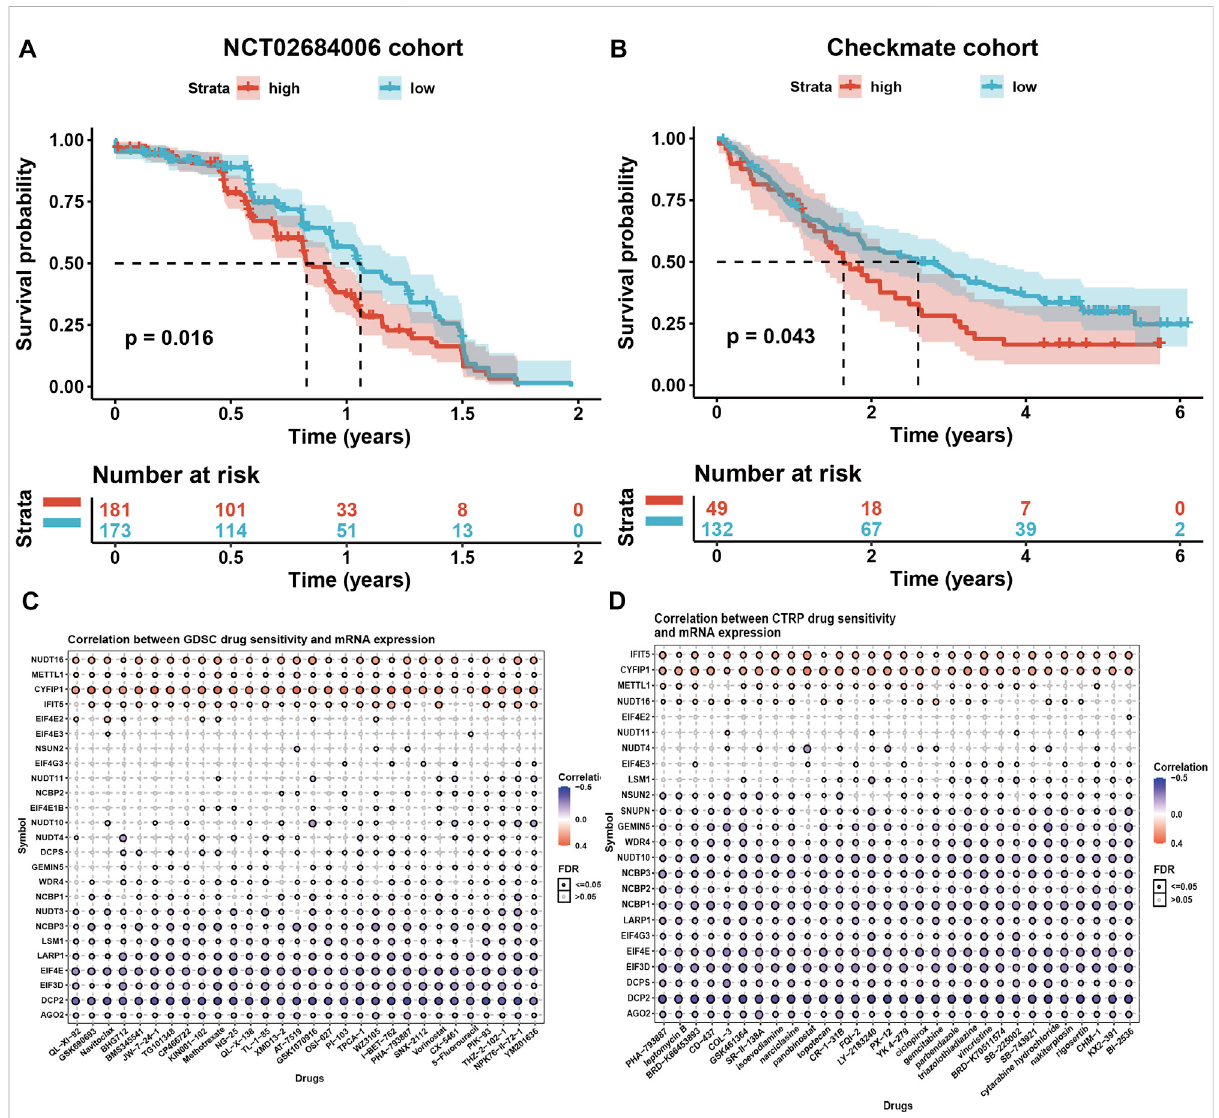
FIGURE 7 Associations of m7G modi fi cation level and immunotherapy and drug sensitivity. (A) High m7G modi fi cation level corelated to the low OS in advanced RCC patients with anti-PDL1 antibody treatment. (B) High m7G modi fi cation level corelated to the low OS in advanced clear cell RCC patients with anti-PD1 antibody treatment. (C,D) Correlation of m7G modi fi cation-related regulator gene expressions and drug sensitivity using GDSC and CTRP